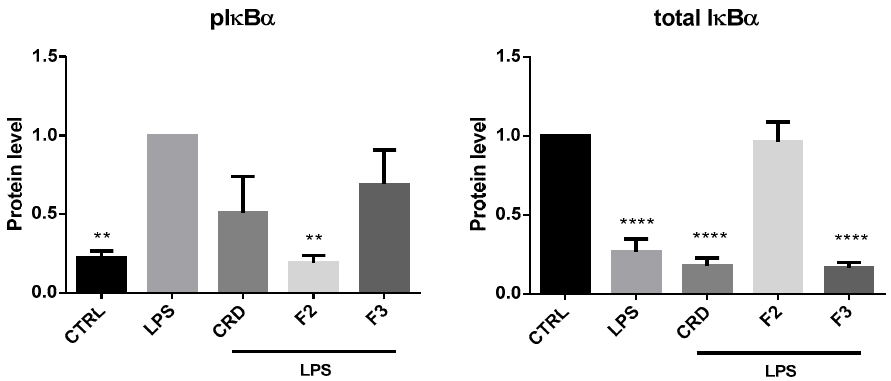
Figure 3. Effects of crude extract, F2 and F3, on the activation of the NF- κ B signaling in LPS-stimulated Raw 264.7 cells after 15 min ( p I κ B α ) and 25 min (I κ B α ) of incubation. The immunoblots presented are representative of 3 independent blots. * p < 0.05, ** p < 0.01 and **** p < 0.0001 indicate significantly differences from the positive control (with LPS) for p I κ B α and negative control (CTRL, without LPS) for I κ B α , as determined by one-way ANOVA followed by Dunnett’s post hoc test. CRD—Crude extract.